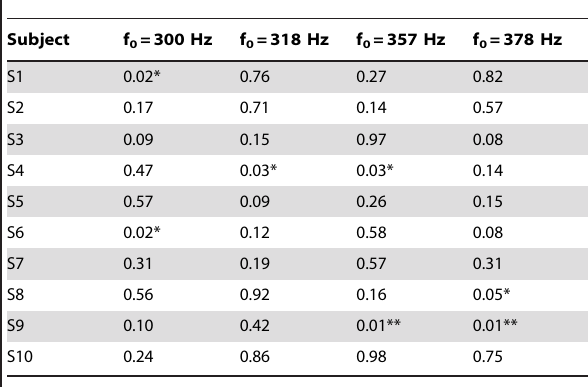
Note: The table shows uncorrected p-values for the slope of individual regression lines (matched tones regressed on timbre levels for